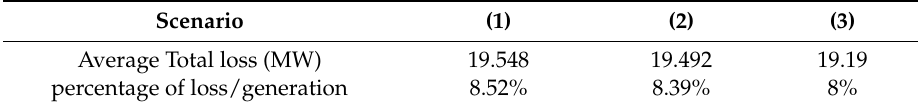
Table 1. Statistical results with two datacenters.